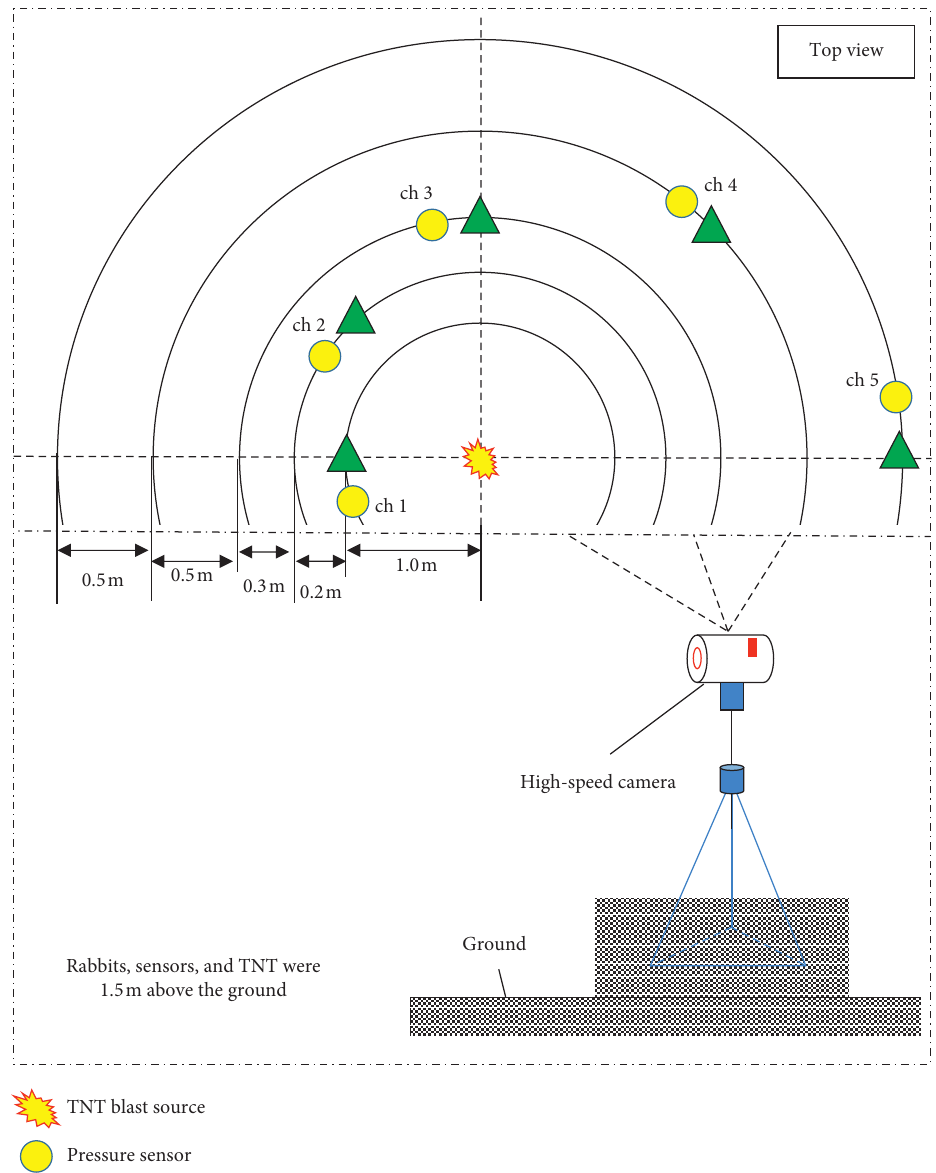
Figure 1: Schematic diagram of experimental site